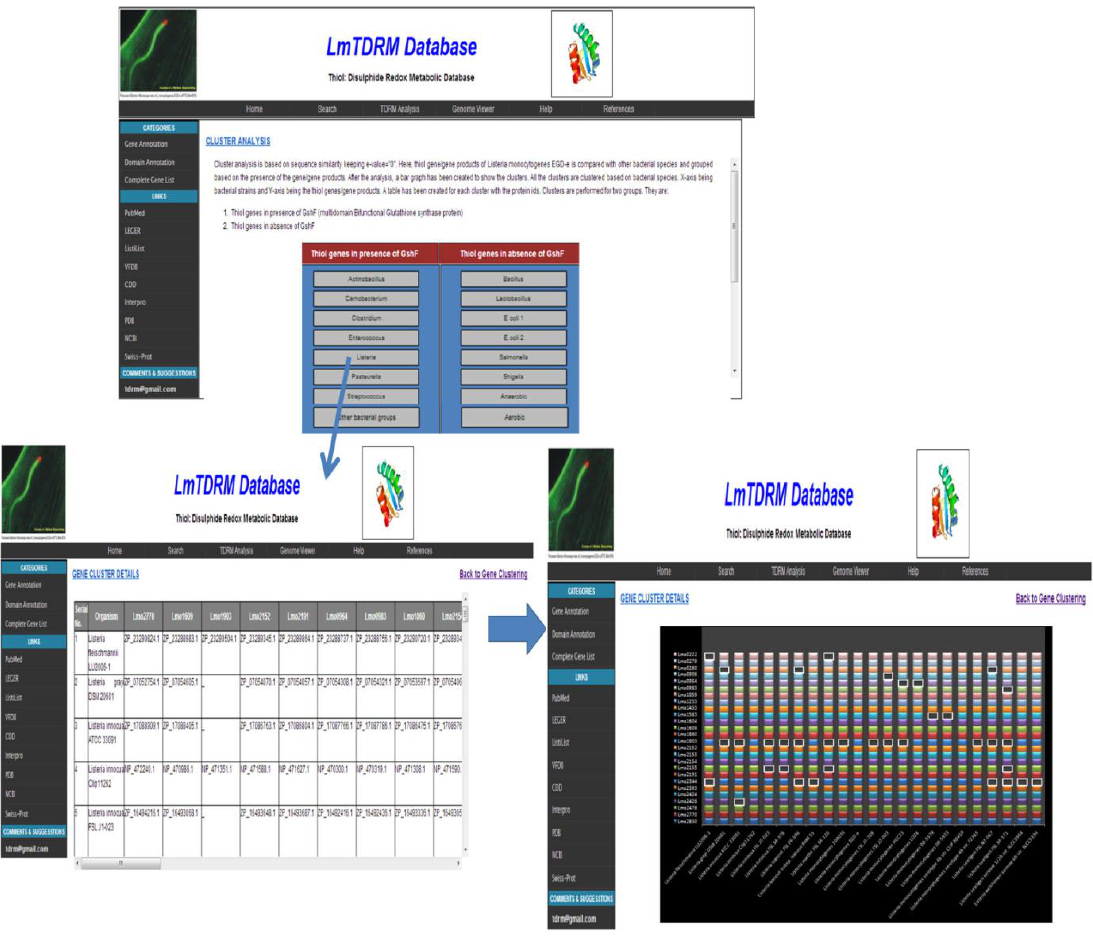
Figure 2: LmTDRM database: screenshot of the cluster analysis. Graph represents the presence of gene/gene products across the bacterial strains. X-axis represents bacterial strain and Y-axis represents thiol